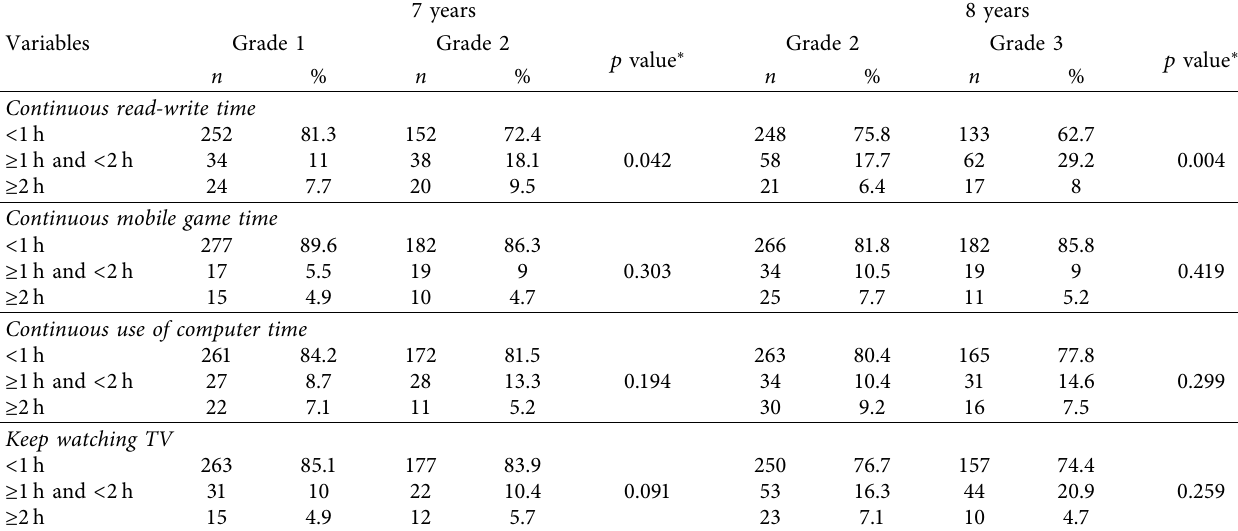
Table 4: Comparison of variables among the grade groups in 7- and 8-year-old students.